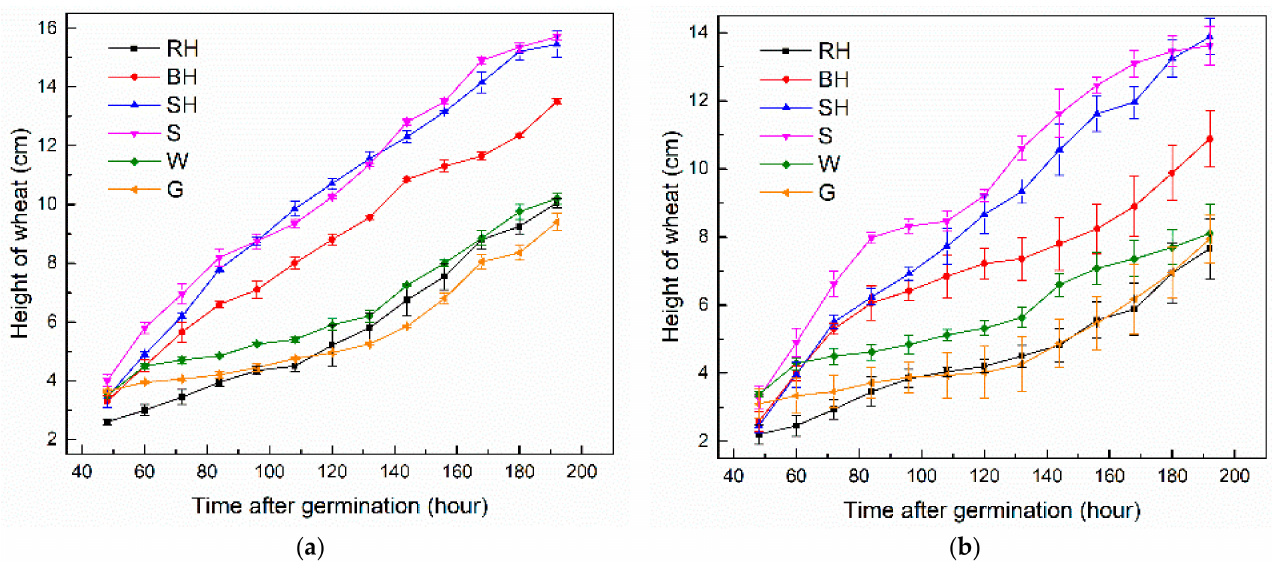
Figure 9. Height of wheats grown in biochar prepared using HPR. ( a ) The top two highest plants (numbered as H 1-2 ); ( b ) the other six plants except the top two (numbered as H 6 ). Values are presented as mean ± SD.